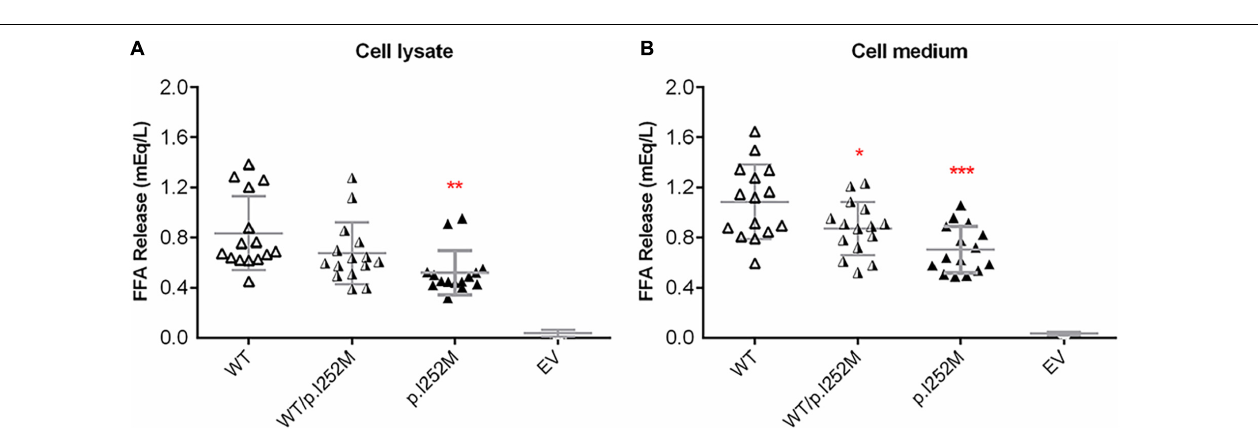
FIGURE 6 | Post-heparin LPL activity in transfected HER293T cell lysates (A) and medium (B) . Results were expressed as mean ± SD from three independent transfections, with each transfection being performed in five replicates. LPL, lipoprotein lipase; WT, wild-type; EV, empty vector. * p < 0.05; ** p < 0.01; *** p <